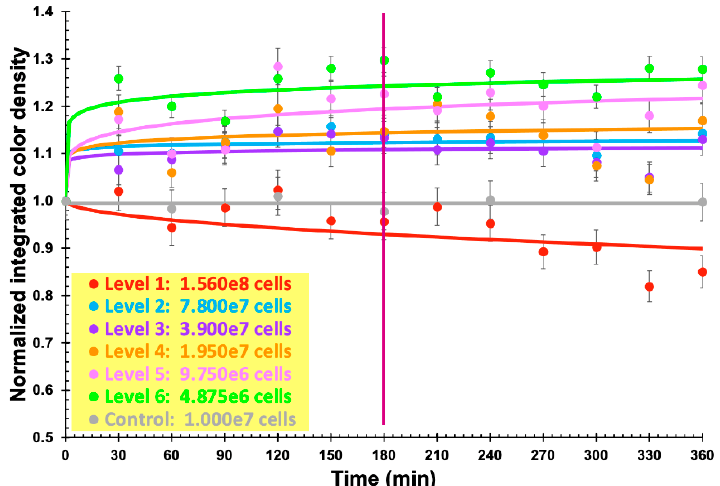
Figure 10. Normalized integrated color density of the optimized bio-reactive chromogel integrating phage particles, sodium 1,2-naftoquinone-4-sulfonate, gelatin, and casein, further added with variable amounts of P. aeruginosa cells, throughout the bioreaction time. Cells of S. aureus CCCD-S009 were used as a control for the bio-detection assays. Values represent the mean of three independent assays. Error bars represent the standard deviation.